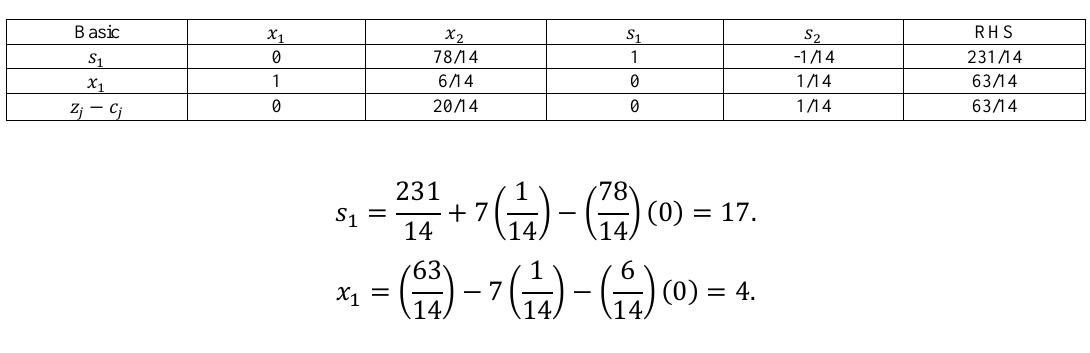
Table 1. Optimal LP